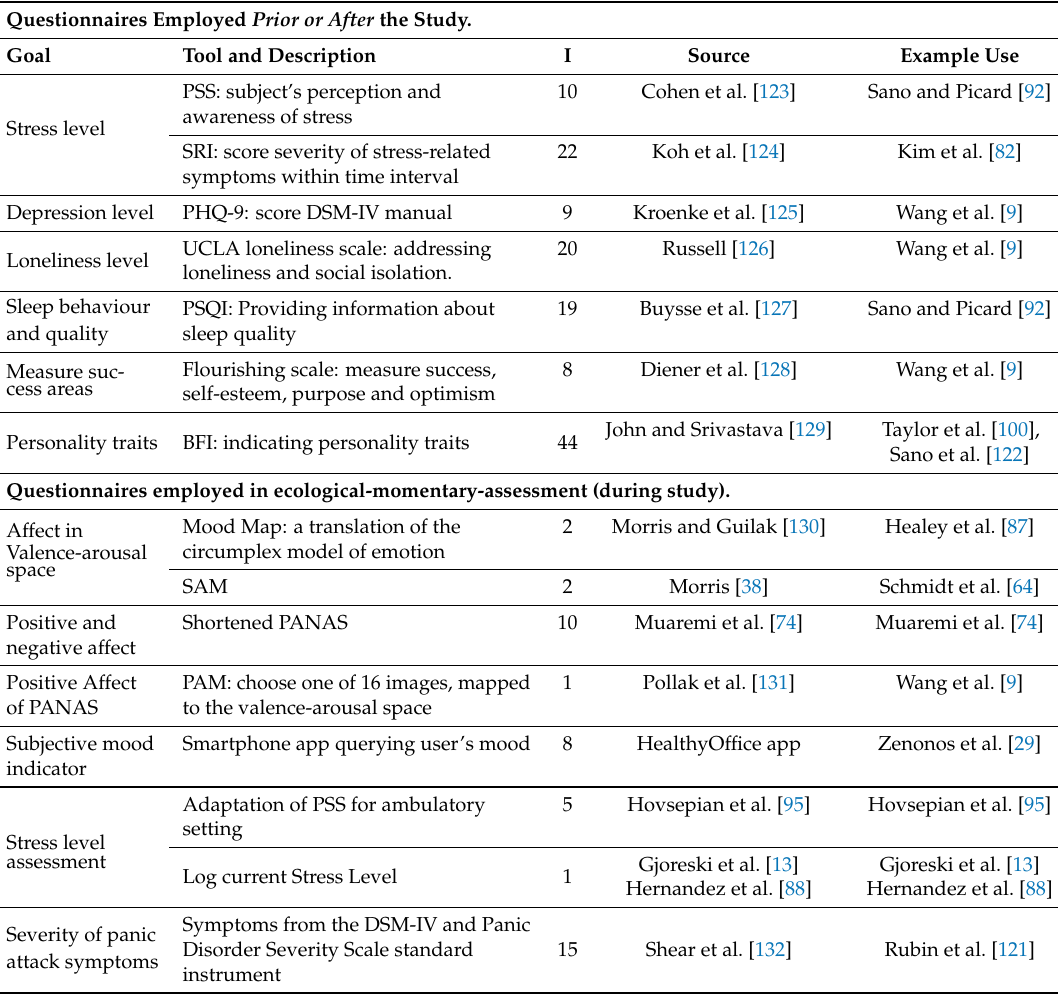
Table 5. Questionnaires utilized in recent wearable-based AR field studies. Abbreviations: Number of Items (I), Big Five Inventory (BFI), Photo Affect Meter (PAM), Positive and Negative Affect Schedule (PANAS), PHQ-9, Pittsburgh Sleep Quality Index (PSQI), Perceived Stress Scale (PSS), Self-Assessment Manikins (SAM), Stress Response Inventory (SRI), Stait-Trait Anxiety Inventory (STAI). Questionnaires Employed Prior or After the